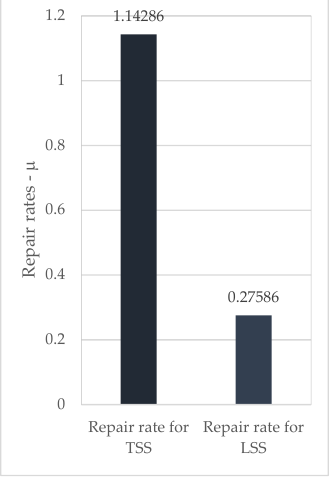
Figure 10. Failure rates — λ CSS, λ TSS, and λ LSS .